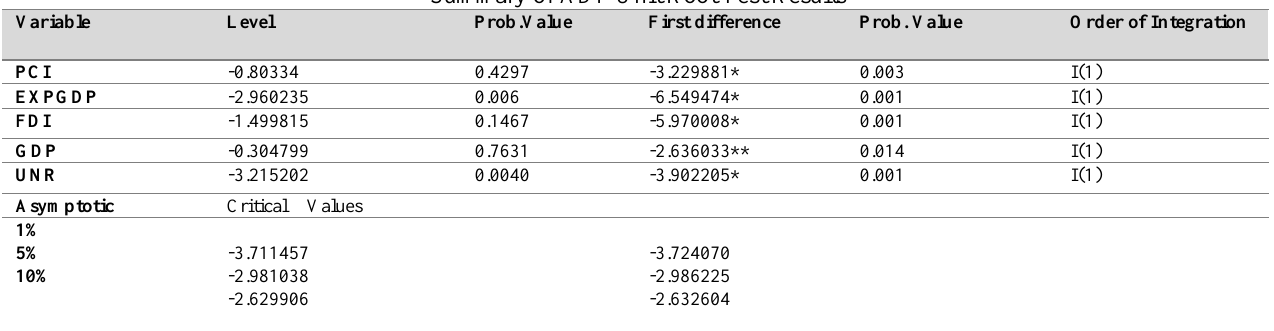
Summary of ADF Unit Root Test Results